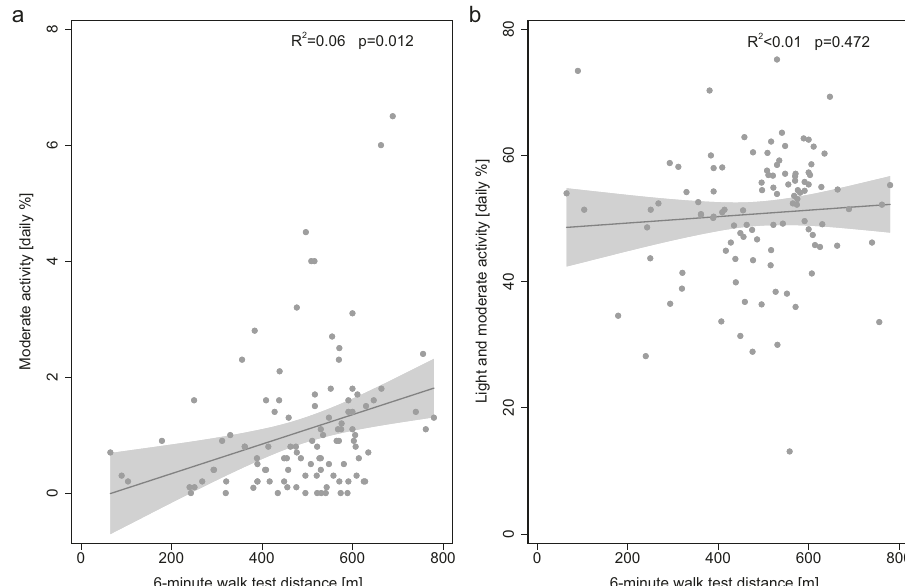
Fig. 3 Relationship between 6-minute walk distances and the percent time spent at different heart rate-based activity levels (without consideration of anthropometric and demographic parameters). a Six-minute walk distances in meters plotted against daily time spent in moderate activity ( R 2 = 0.059, p = 0.012). b Six-minute walk distances in meters plotted against time spent in combined light and moderate activity ( R 2 = 0.005, p = 0.472). m meters.